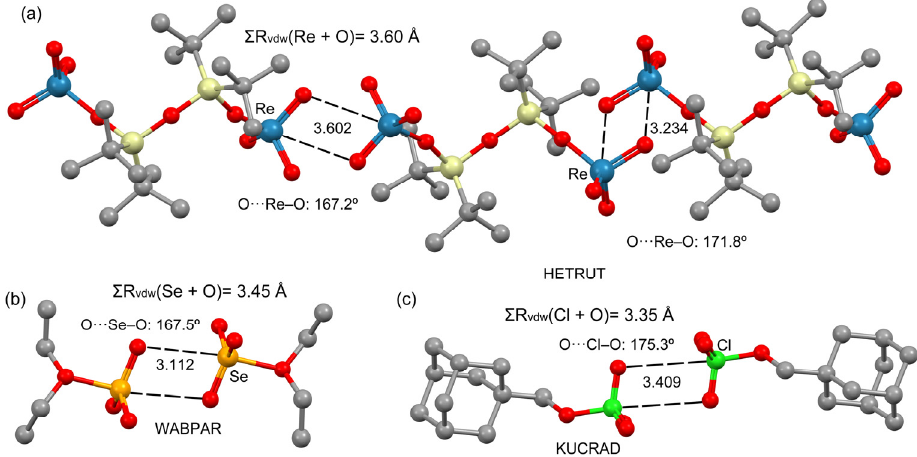
Figure 2. Partial views of the X-ray structures of HETRUT ( a ), WABPAR ( b ) and KUCRAD ( c ). H-atoms omitted for clarity. Distances in Å. The sums of Batsanov’s van der Waals radii (R vdw ) are also indicated.